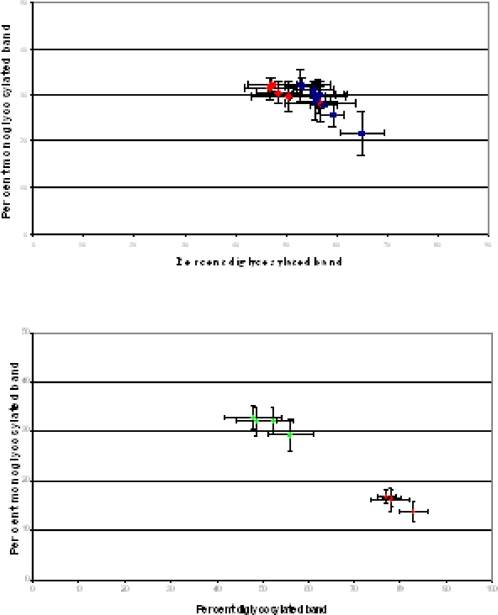
Glycoform ratios of PrPres from “CH1641-like” isolates in TgOvPrP4 mice.Glycoform ratios of PrPres in individual mice inoculated with ovine or bovine isolates (first passage) are shown in (A) and (B), respectively. In (A), CH1641 is shown in red, and natural isolates 06-017 and 05-0825 in blue. In (B), Classical and L-type BSE are shown in red and green, respectively. PrPres was detected by Bar233 antibody.